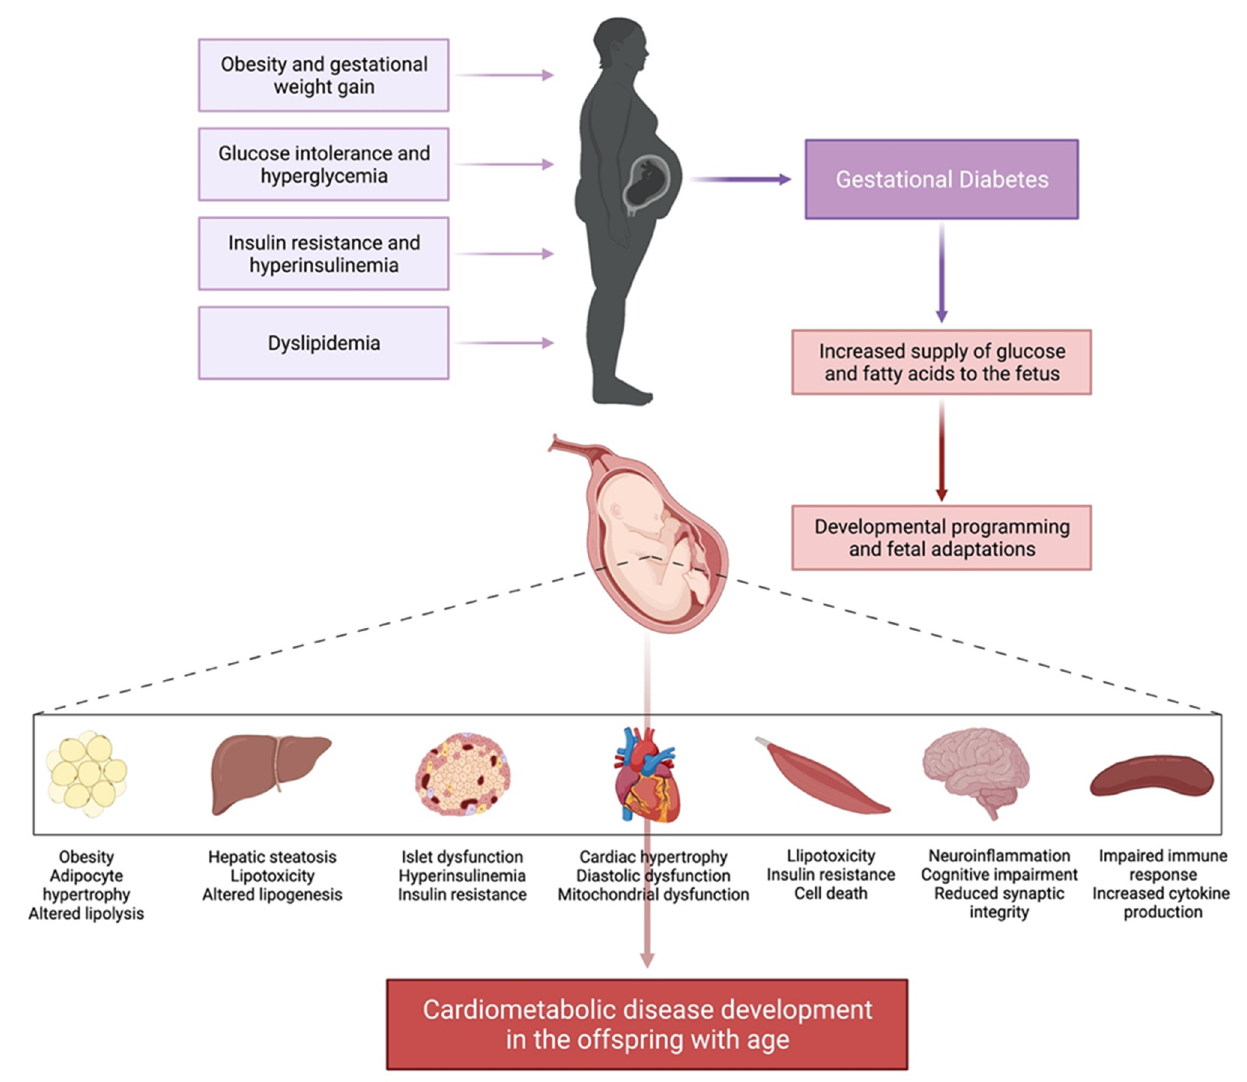
Figure 1. Influence of maternal obesity and gestational diabetes mellitus (GDM) on the developmental origins of cardiometabolic disease in the offspring. Obesity, dysglycemia and hyperlipidemia pre-pregnancy and during pregnancy contribute to the development of GDM. GDM increases the supply of glucose and fatty acids to the fetus which results in fetal adaptations and developmental programming that include alterations in gene expression, organogenesis, cellular metabolism and epigenetic modifications. GDM exposure appears to affect a wide range of cellular, tissue and organ systems in a manner that increases the risk of cardiometabolic disease in the offspring with increasing evidence from rodent model systems that the cardiovascular system is sensitive to GDM-induced effects. Created with BioRender.com.